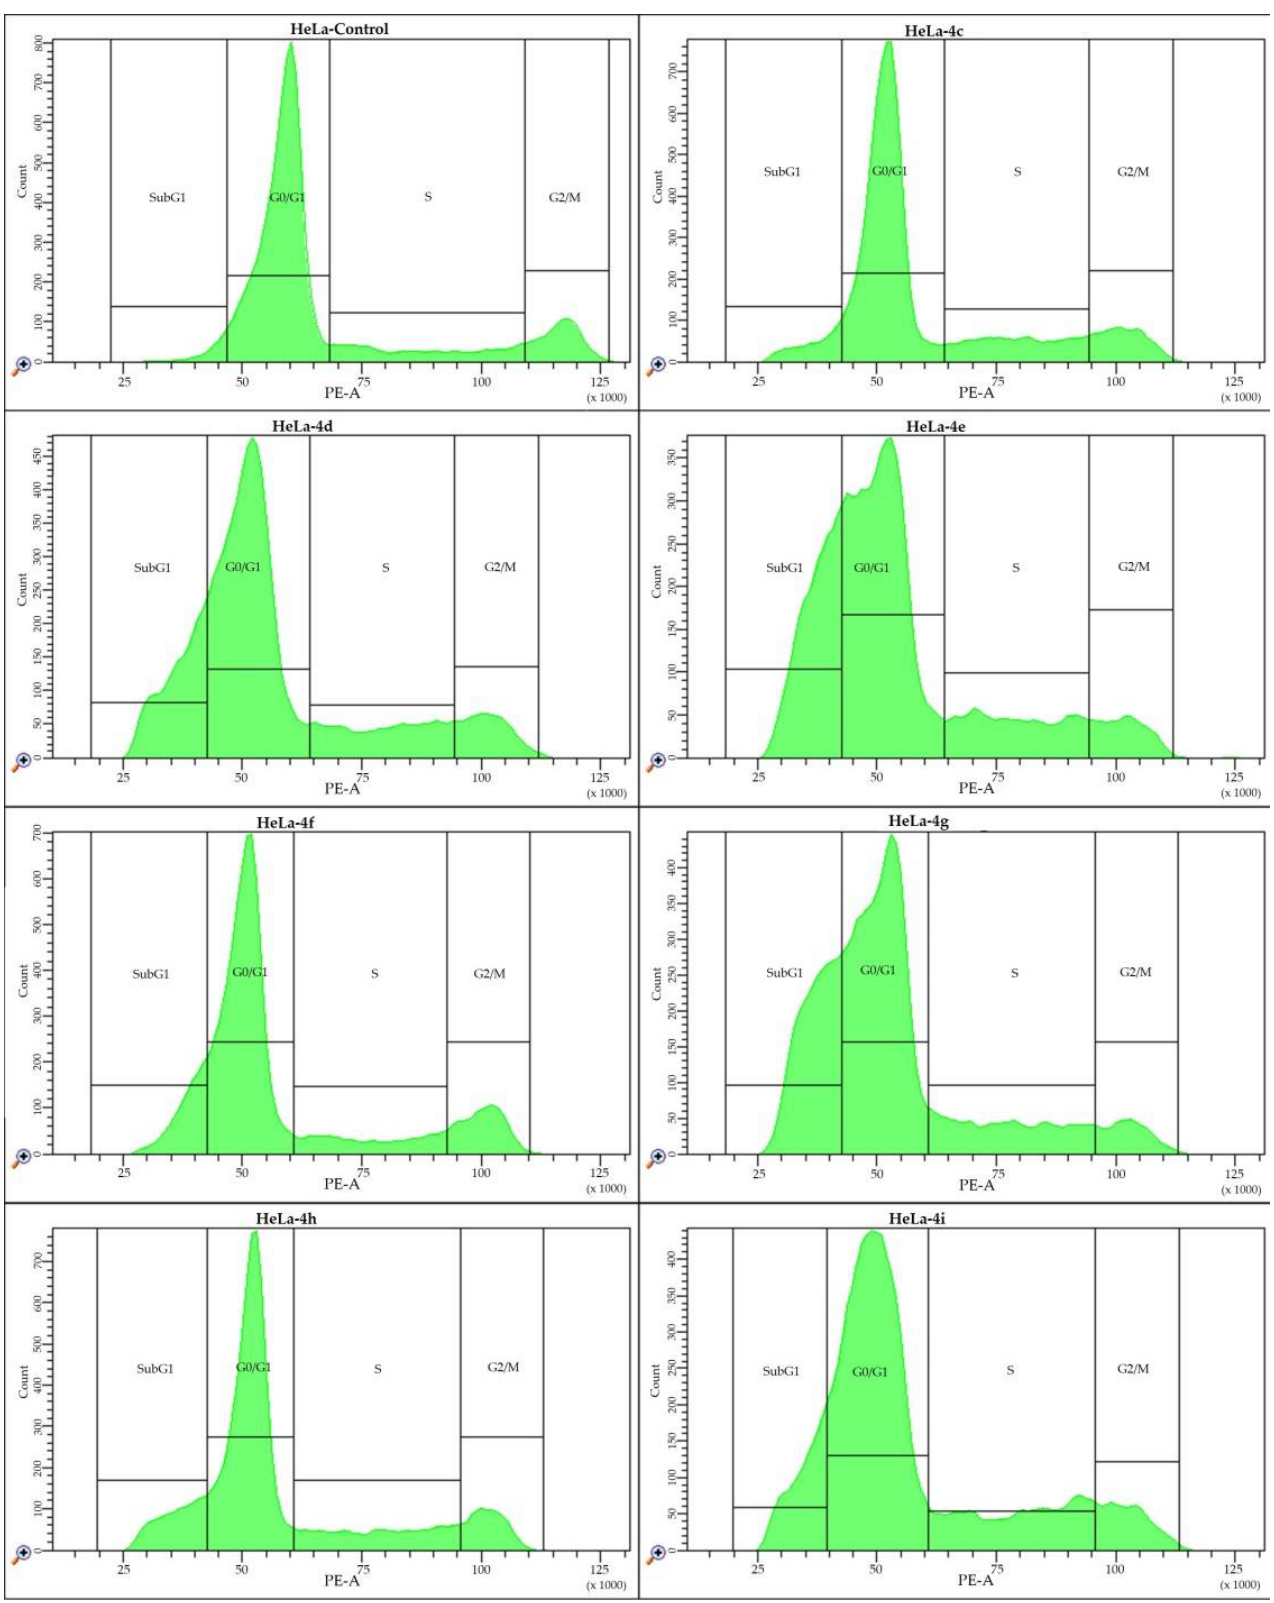
Figure 8. Effect of cycloadducts 4c–i at concentration 10 μg/mL on the distribution of HeLa cells in the cell cycle.